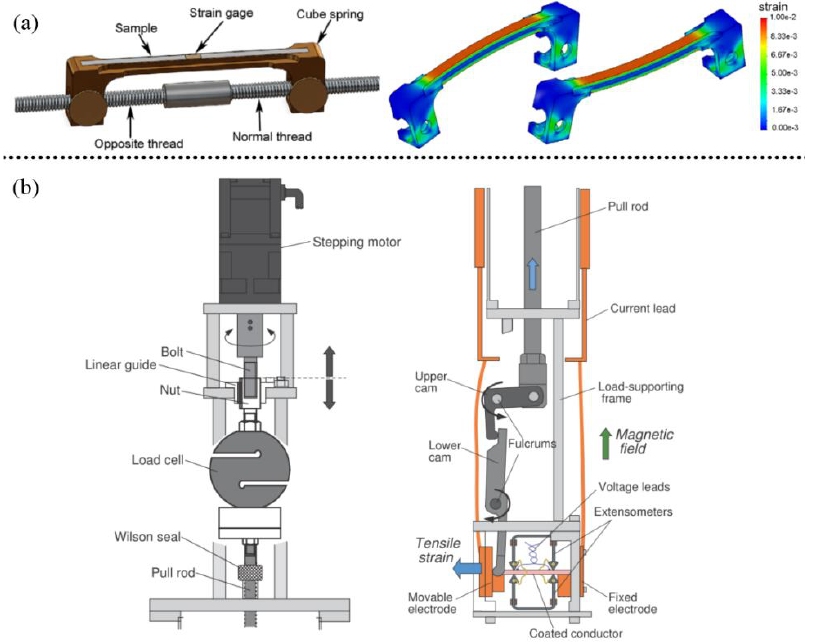
Figure 1. ( a , b ) Different methods of applying strain. Reprinted with permission from Refs.